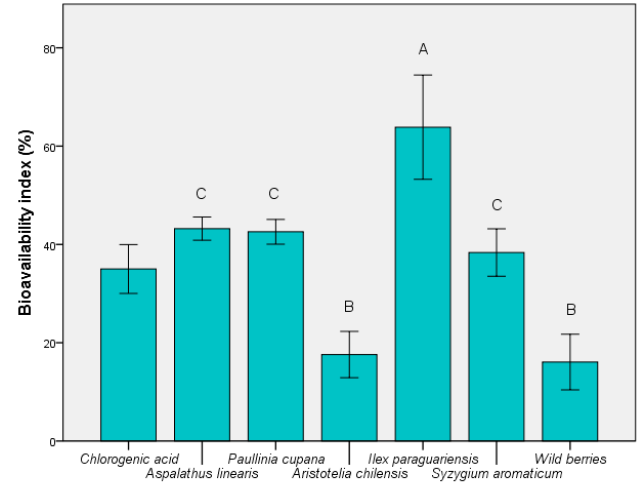
Figure 4. Bioavailability index of extracts based on S. boulardii in vivo model. Different letters represent significant statistical differences (chlorogenic acid vs. samples; p ≤ 0.05), n = 3; chlorogenic acid was used as control.